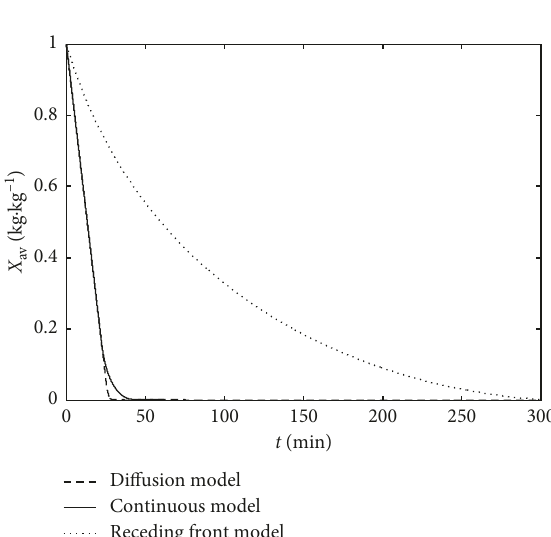
Figure 9: Evolution of average moisture content for isothermal drying of a spherical particle using different drying models.